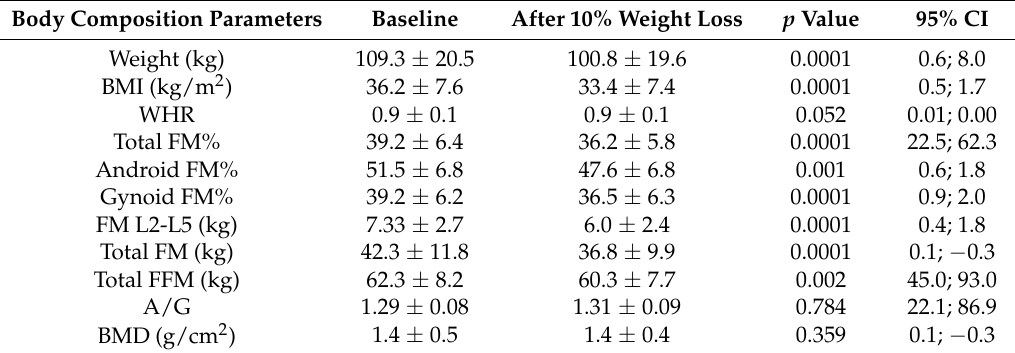
Table 2. Body composition parameters at baseline and after 10%weight loss. Body Composition